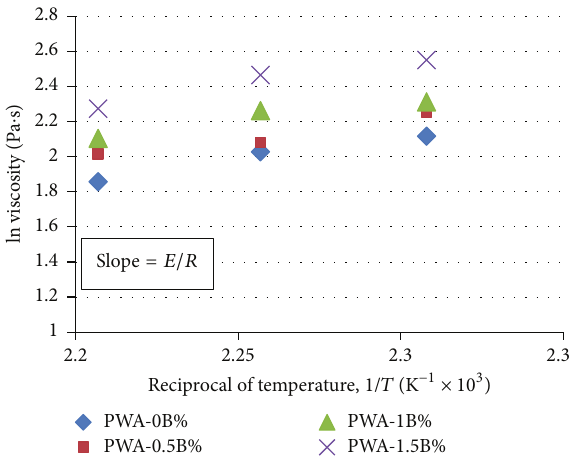
Figure 7: A relationship between viscosity and temperature for various PWA- 𝑛 B